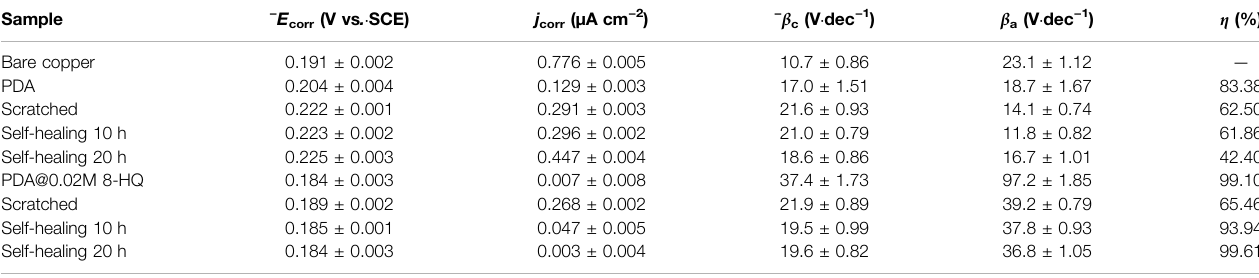
TABLE 4 | Anticorrosion performance obtained from potentiodynamic polarization curves recorded with the self-healing tests on PDA@Cu and PDA@0.02 M 8-HQ@Cu samples. Sample